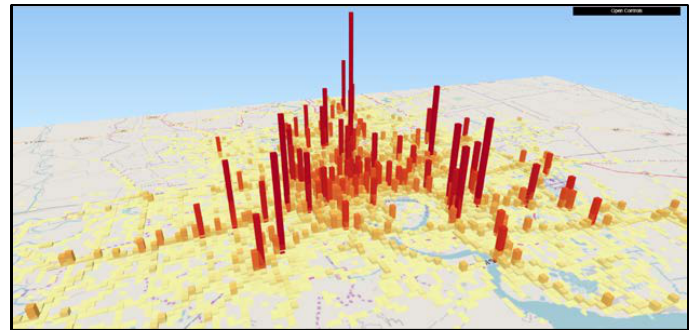
Figure 10. Aggregated taxi demand at time interval. Top : 7–8 a.m.; Bottom : 18–19 p.m.